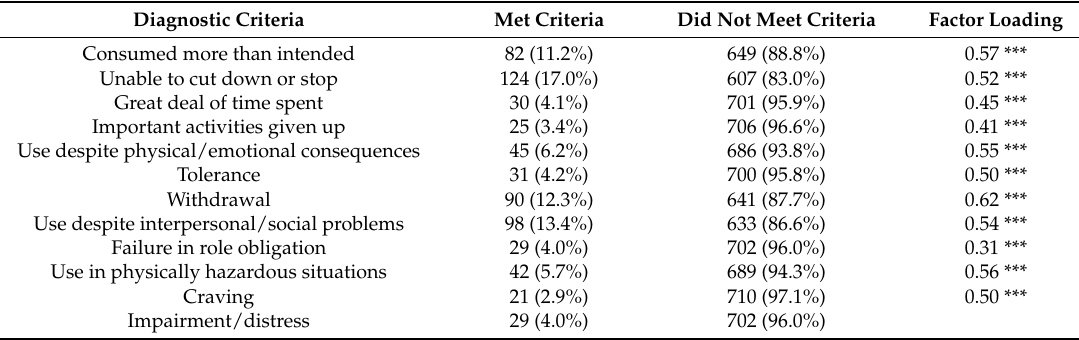
Table 2. Diagnostic criteria of the Japanese version of the Yale Food Addiction Scale 2.0 ( n =